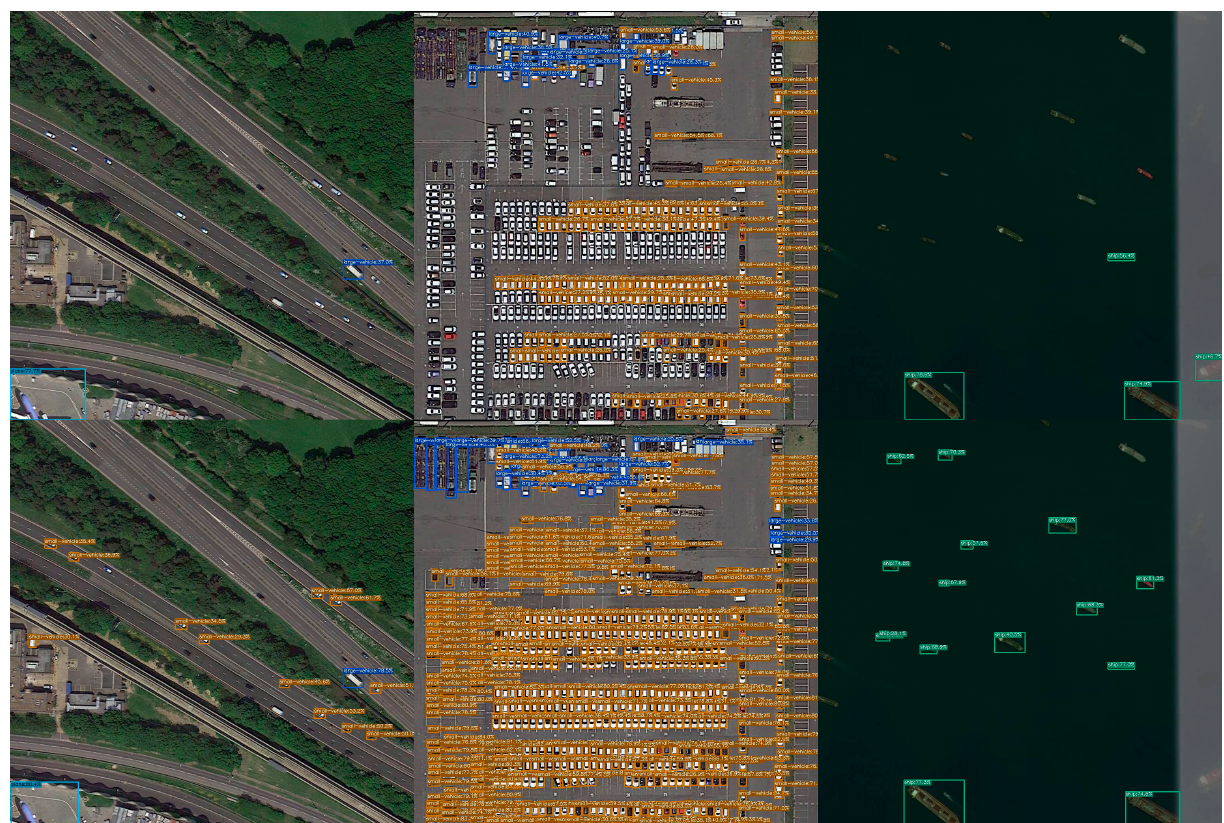
Figure 6. Comparison chart before and after improvement. The upper part is before improvement, and the lower part is after improvement.